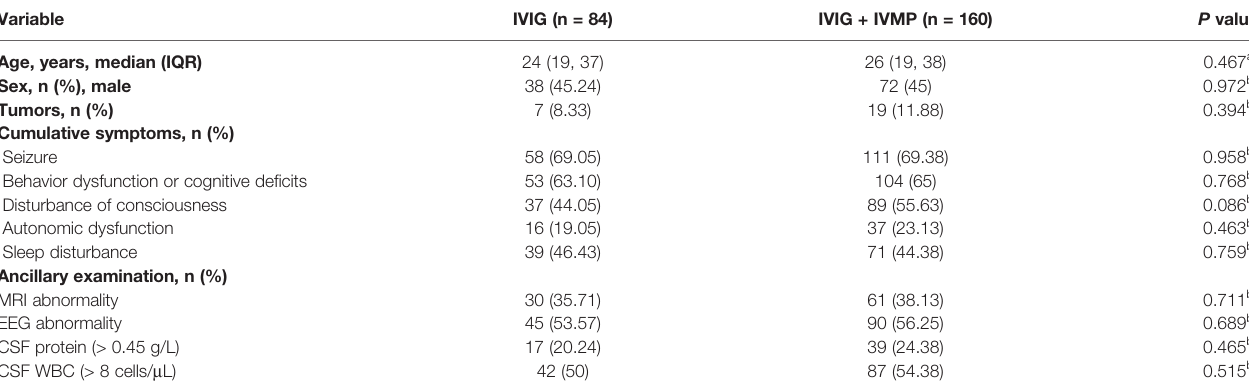
TABLE 1 | Clinical characteristics of anti-NMDAR encephalitis patients in both groups before immunotherapy.